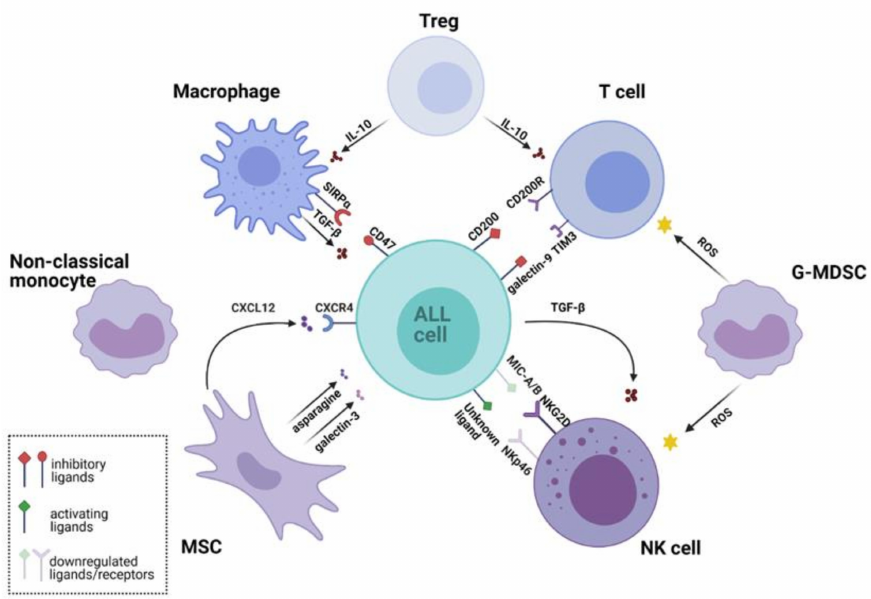
Figure 1. Leukemic microenvironment supports survival of acute lymphoblastic leukemia (ALL) cells and their immune evasion through multiple interactions. Various cell populations shape the leukemic microenvironment. Regulatory T cells (Tregs) secrete inhibitory cytokines that suppress the cytotoxic activity of T cells and reduce macrophage phagocytosis. Granulocytic Monocyte Derived Suppressor Cells (G-MDSC) produce reactive oxygen species (ROS) that inhibit activity of T cells